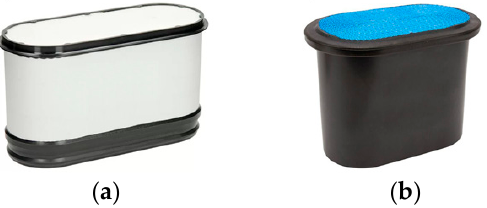
Figure 11. Original PowerCore filter cartridges used to make the test cartridges: ( a ) PowerCore— standard, ( b ) PowerCore G2 (author’s photos).